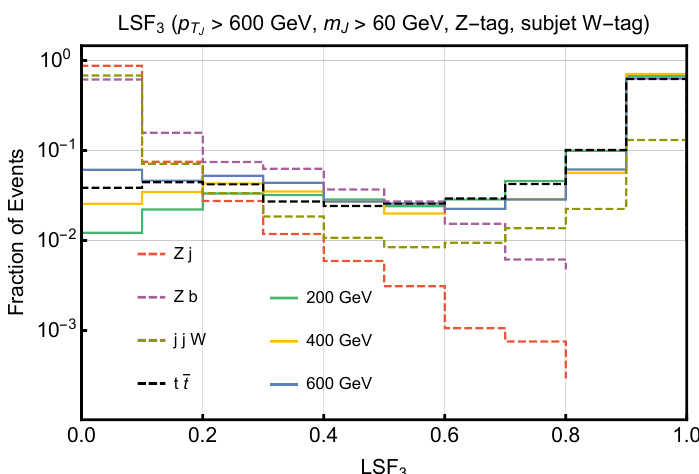
Figure 7. LSF 3 distribution for signal (for a few values of scalar mass) and four backgrounds: Zj; Zb; jjW and t (cid:22) t